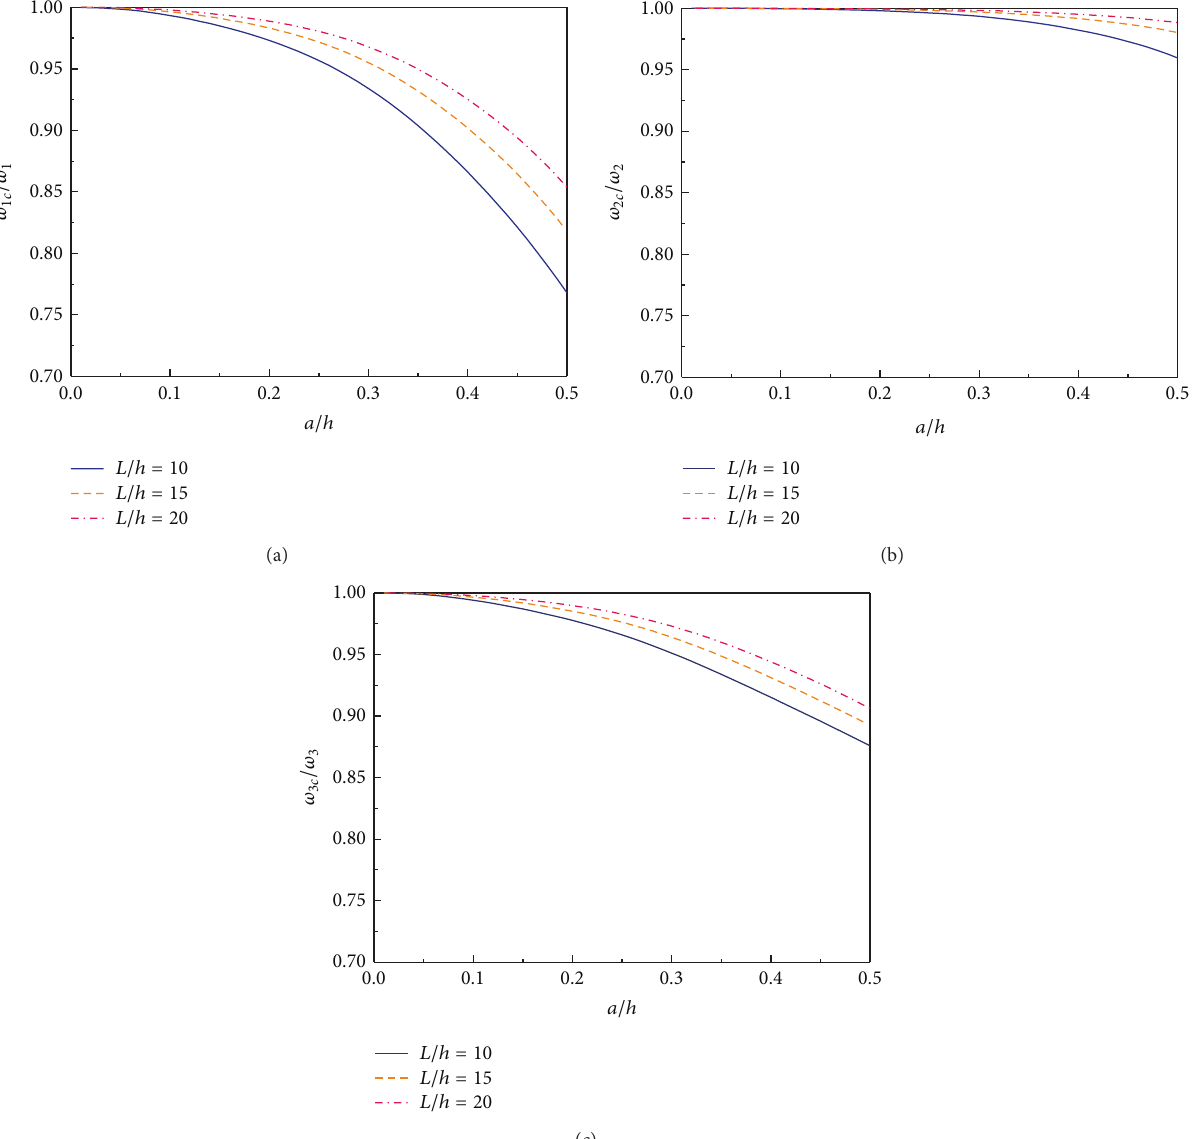
Figure 6: The first three frequency ratios of hinged-hinged isotropic homogenous beams with different slenderness ratios and containing a single open edge crack of varying depths: (a) the fundamental frequency ratio, (b) the second frequency ratio, and (c) the third frequency ratio.